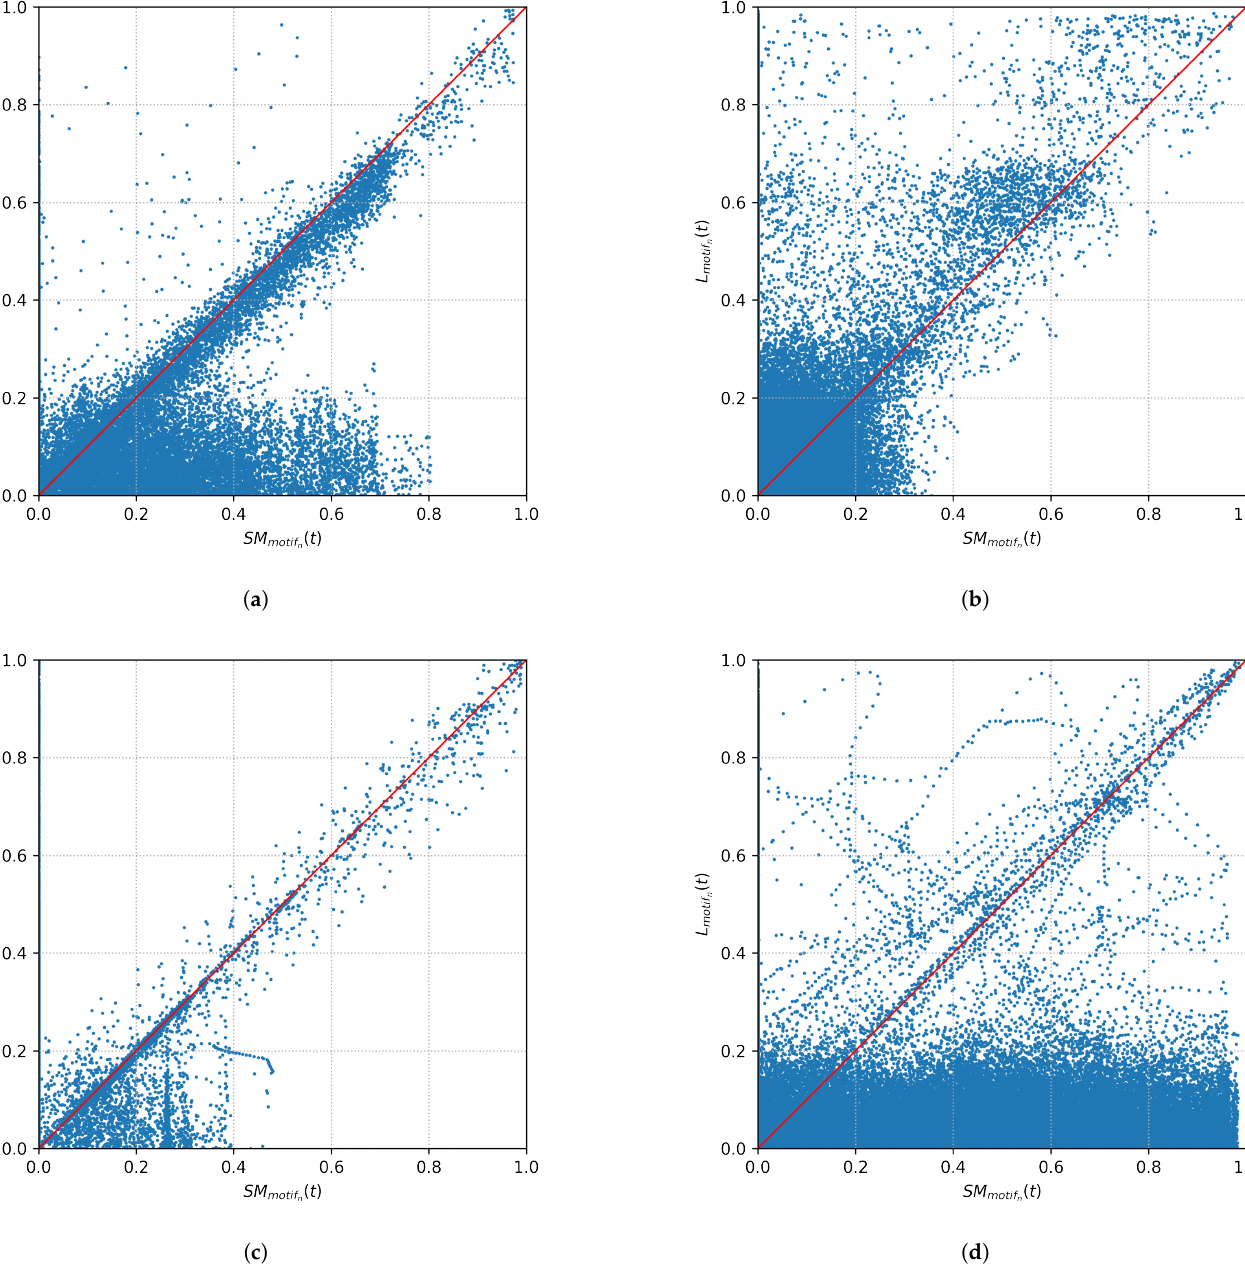
( t ) and SM ( t ) for four exemplary motifs. ( a ) Motif of a fully motif n n